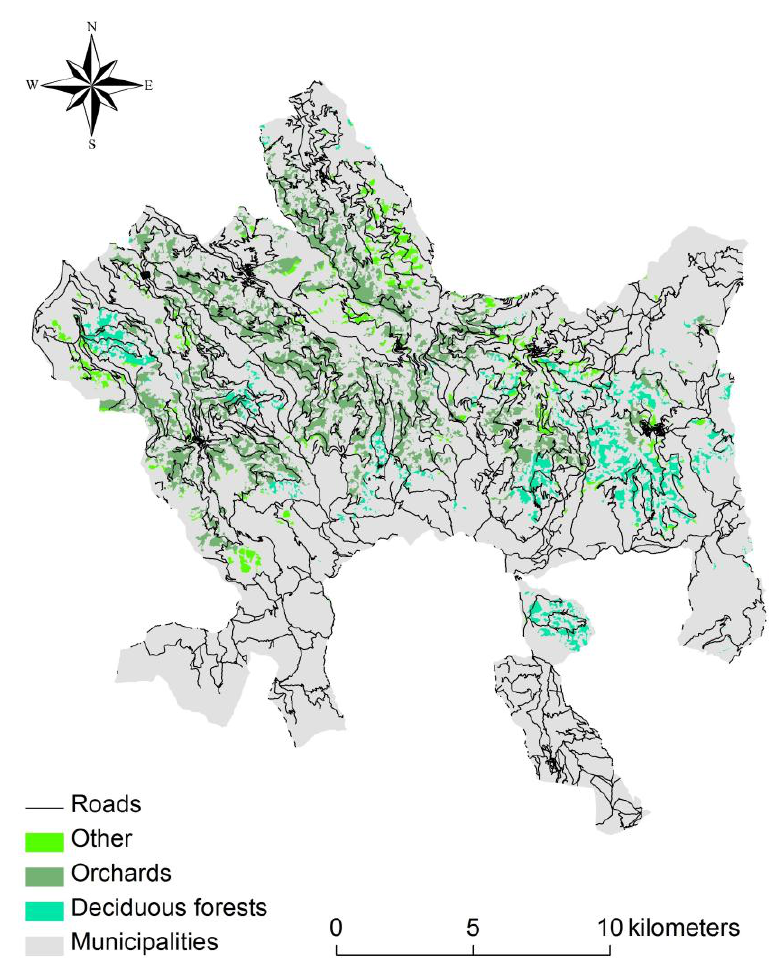
Figure 2. Hazelnut areas identified by the vegetation map of the region of Sicily. Each plot corresponds to the land use observed in CLC. Source: own elaboration.